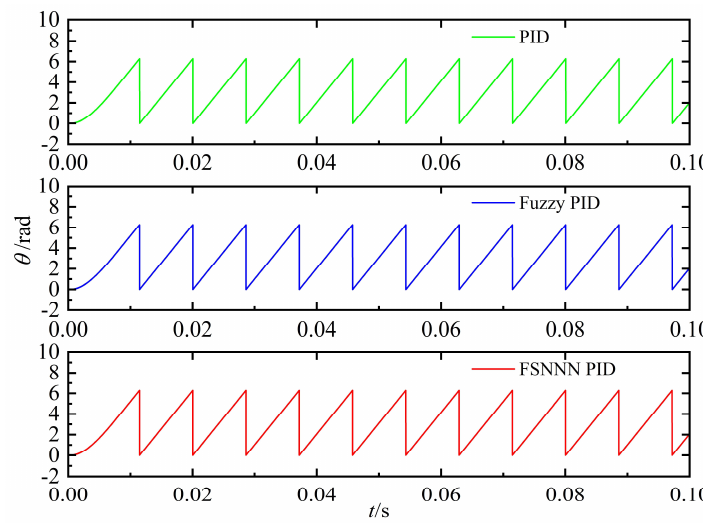
Figure 19. Rotor angle position θ curve.